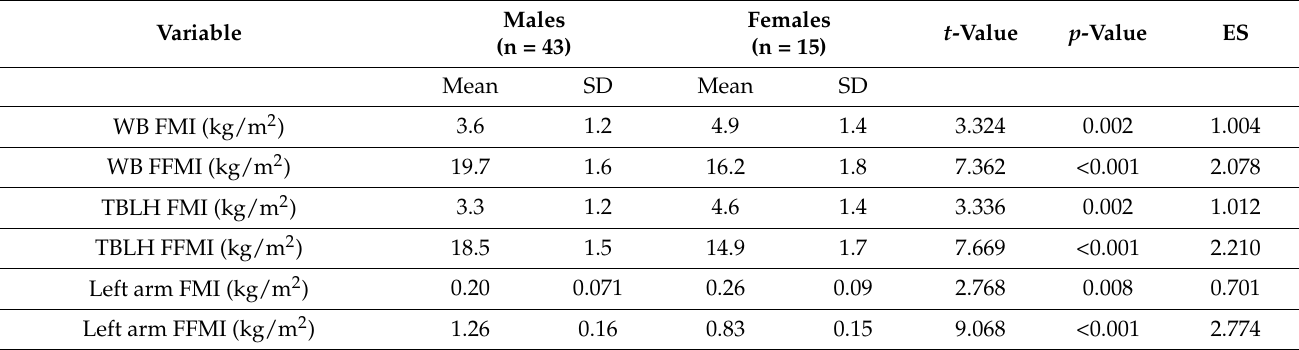
Table 3. Stature-adjusted indices of whole body (WB) and regional fat and fat-free mass in male and female karatekas. Mean ± standard deviation (SD). Student’s t